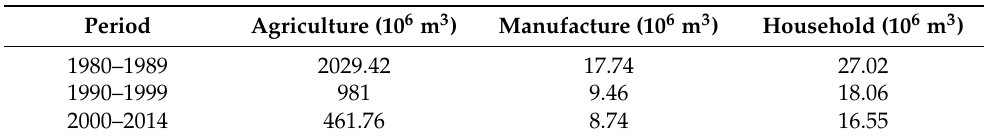
Table 4. The water consumption for agriculture, manufacturing, and household uses in the Issyk-Kul Lake Basin from 1980 to 2014